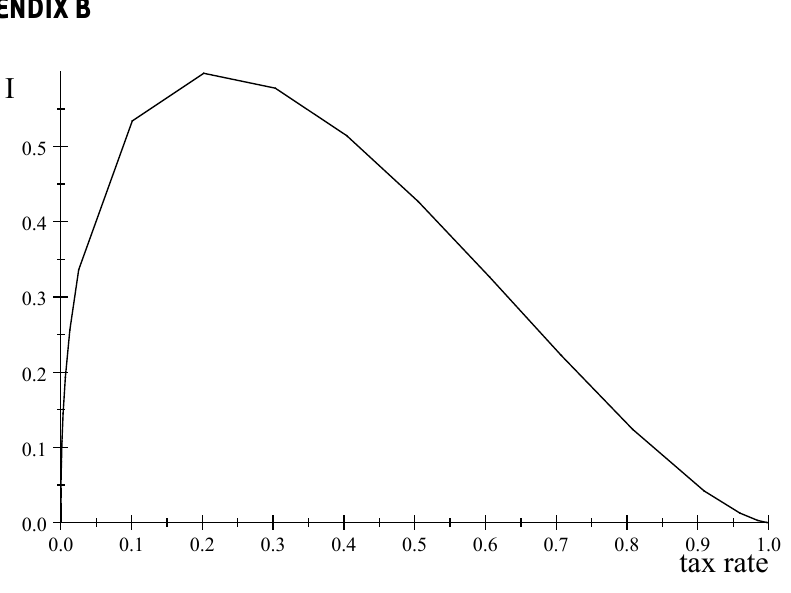
FIGURE 1: The effect of tax on the relative size of the informal sector